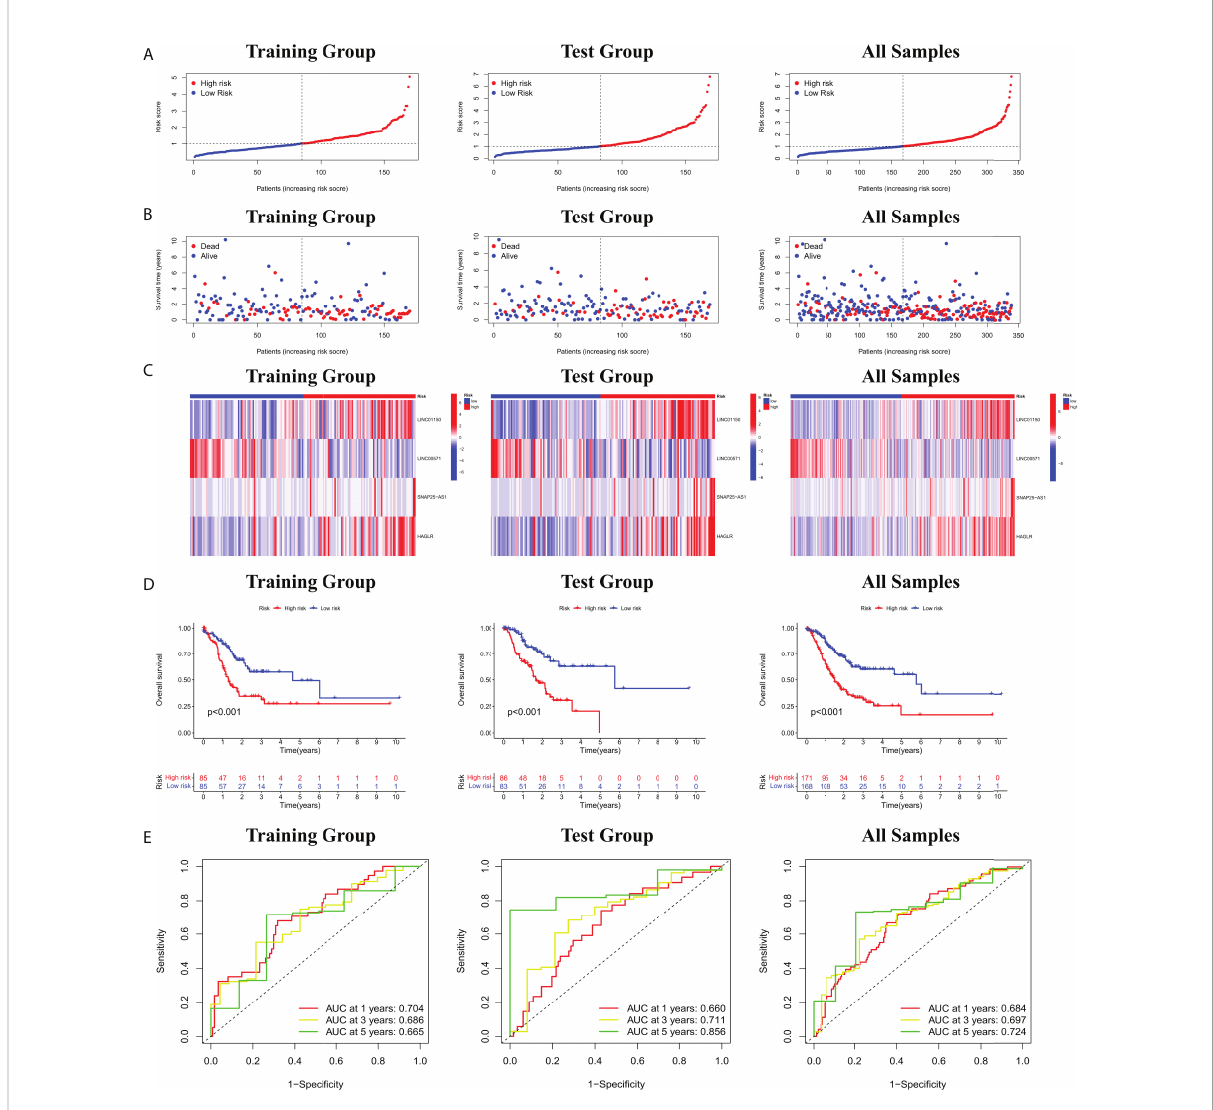
FIGURE 2 (A) Risk score distribution of patients with STAD based on cuproptosis-related lncRNAs. (B) Scatter plots showed the association between the OS and the risk score distribution. (C) Heat maps of expression of the four lncRNAs signals associated with cuproptosis. (D) K-M survival curve on OS status in STAD patients. (E) ROC curve of 1, 3, and 5 years in training and test groups (including all